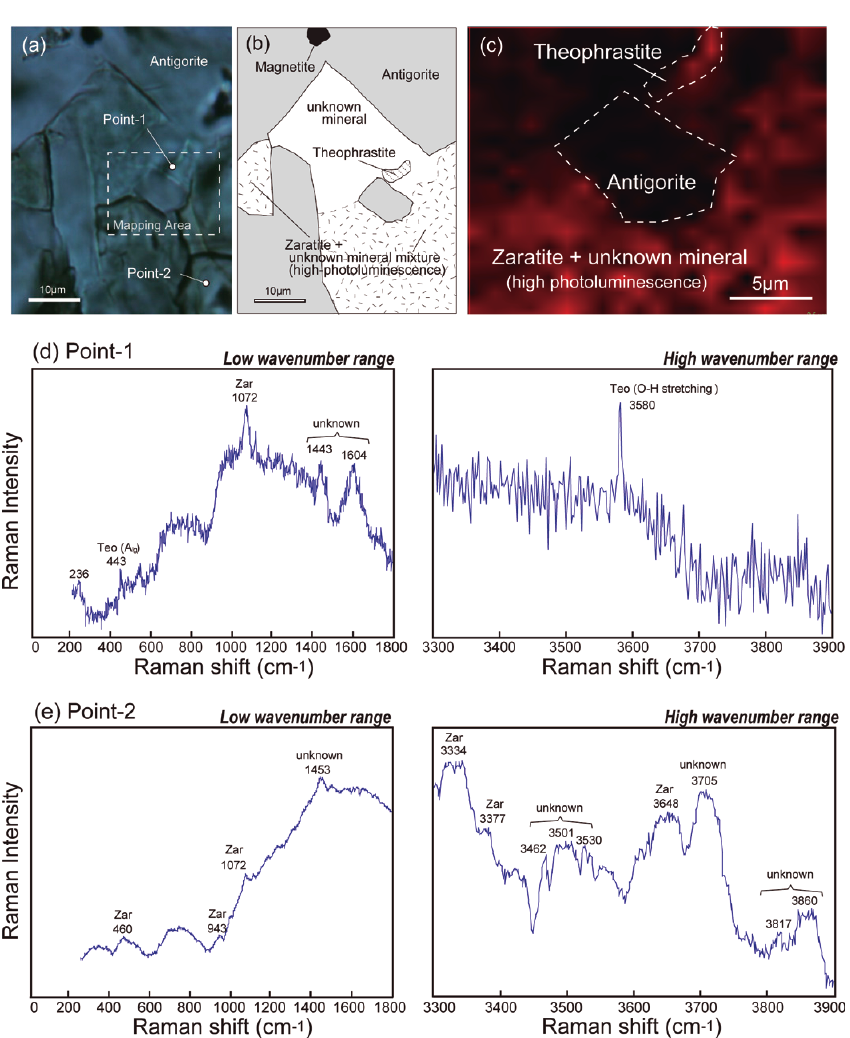
Figure 6. Laser Raman spectroscopy of the theophrastite-zaratite aggregate in the dunite from Fujiwara, Japan. ( a ) Plane-polarized image of the examined area, which is equivalent to the rectangle in Figure 3. The rectangle shows the area for Raman spectroscopic mapping ( c ). Spectra for points 1 and 2 are shown in panels ( d , e ), respectively. ( b ) Summary of identification of mineral species for the area of panel ( a ). ( c ) Distribution of Raman spectral intensity in terms of wavenumber = 3580 cm − 1 , where one of the main peaks for theophrastite is available [37]. Theophrastite was identified only from an encircled area, but the other area shows high photoluminescence, where only zaratite was identified [39]. ( d ) Raman spectra from Point 1 (panel ( a )), where theophrastite was identified. Note a prominent band at 3580 cm − 1 caused by O-H stretching vibrations of theophrastite [37]. ( e ) Raman spectra from Point 2 (panel ( a )), where only zaratite was identified with high photoluminescence background. Teo, theophrastite. Zar,